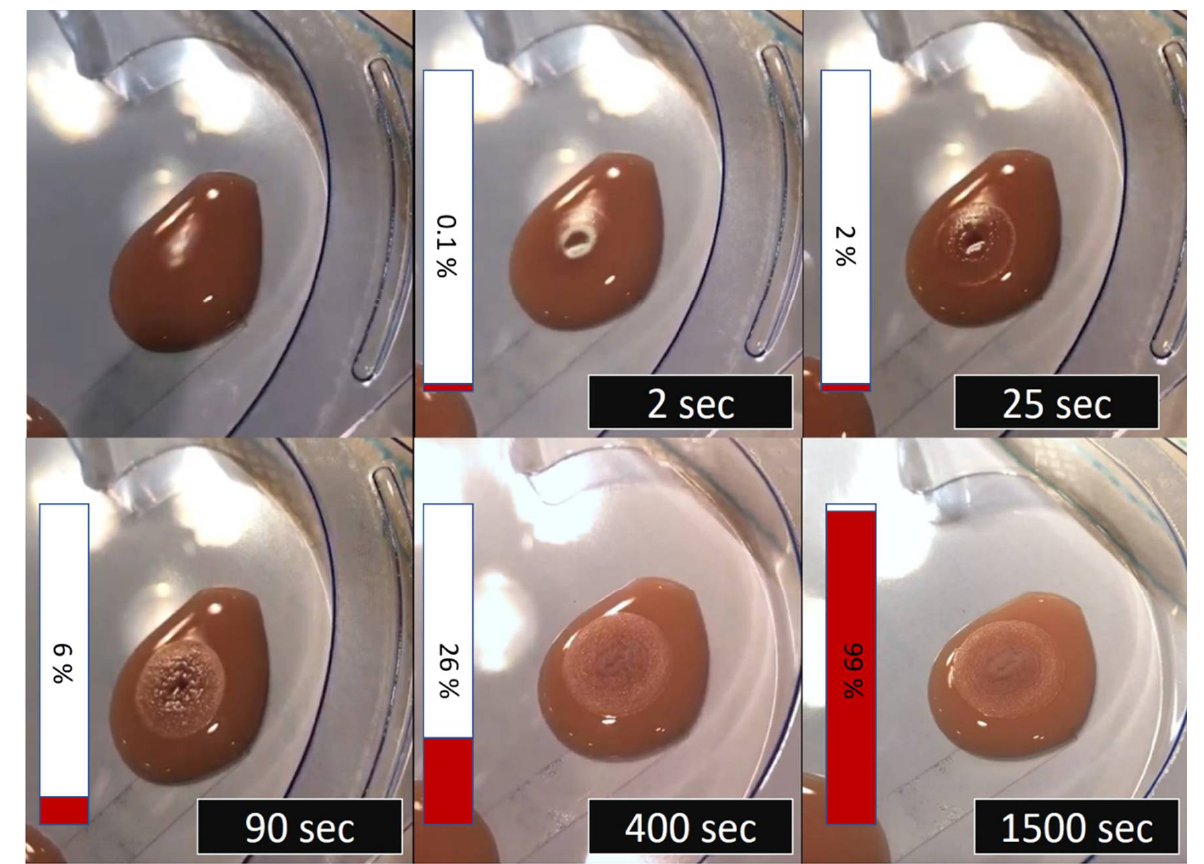
Figure 1. Example of typical static embolization testing setup. HA/iodized oil (in this case, with a ratio of 1:4) is dropped into a lymphatic sample (in this case, triglyceride content: 1111 mg/dL). The polymerization process is continuously monitored with a high temporal resolution camera (temporal resolution 0.07 s). The cessation of morphologic change marks the end of the experiment. The red and white bar on the left side of the images displays the percentage of total polymerization time.